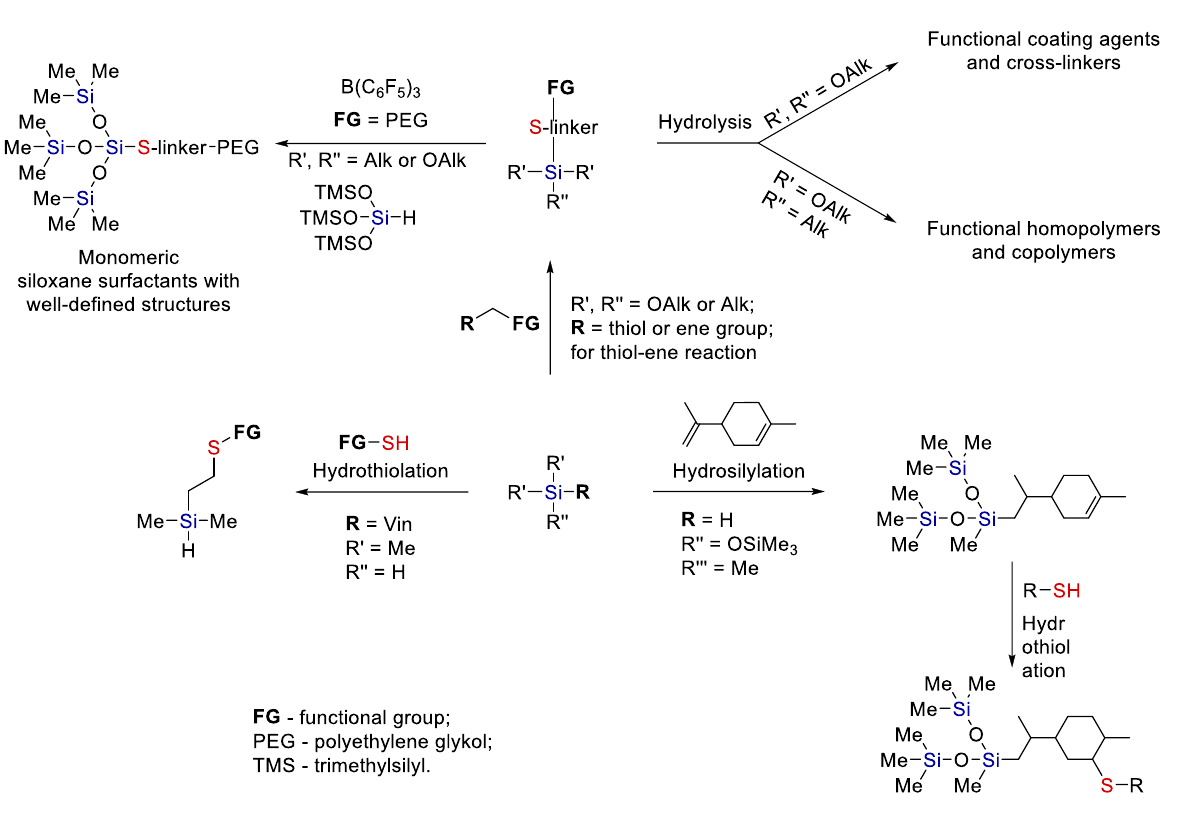
Figure 14. A general scheme for the modification of organosilicon compounds by thiol-ene addition combined with other synthetic approaches. Adopted from Refs. [32,38,40,43].